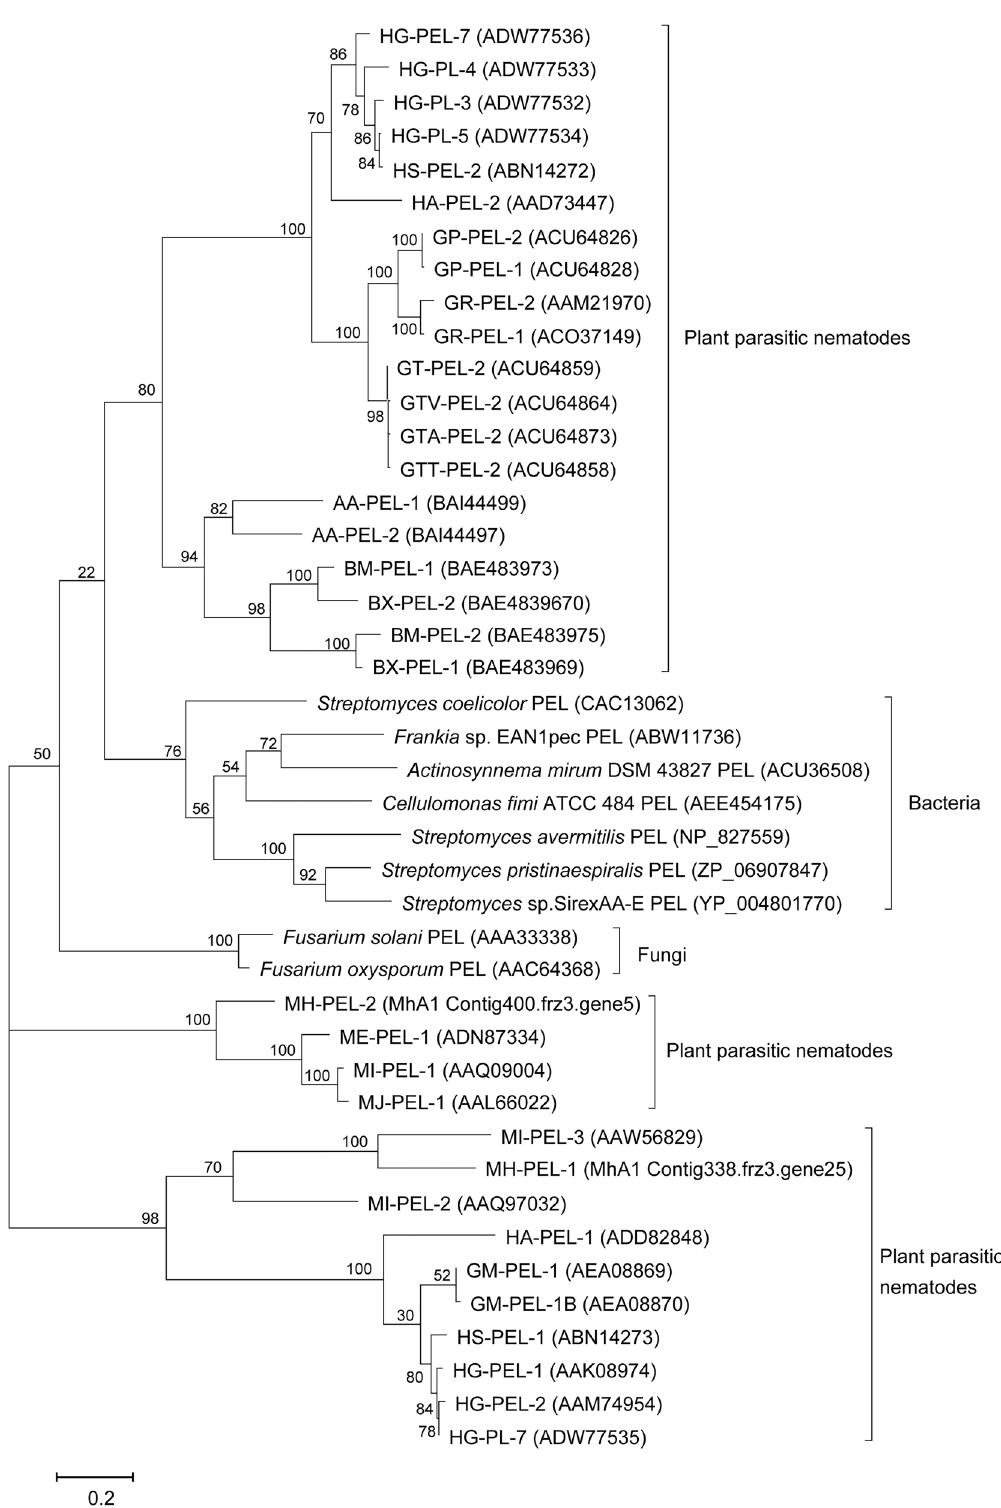
Fig 2. Phylogenetic tree of the polysaccharide lyase family 3 generated using maximum likelihood of PhyML. The numbers next to the branches indicate the bootstrap value. GenBank accession numbers of pectate lyase proteins correspond to Meloidogyne incognita (MI-PEL-1, MI-PEL-2 and MI-PEL- 3), M . hapha (Mh-ENG-1 and Mh-ENG-2), M . javanica (MJ-PEL-1), Globodera rostochiensis (GR-PEL-1and GR-PEL-2), G . pallida (Gp-ENG-1 and Gp-ENG-